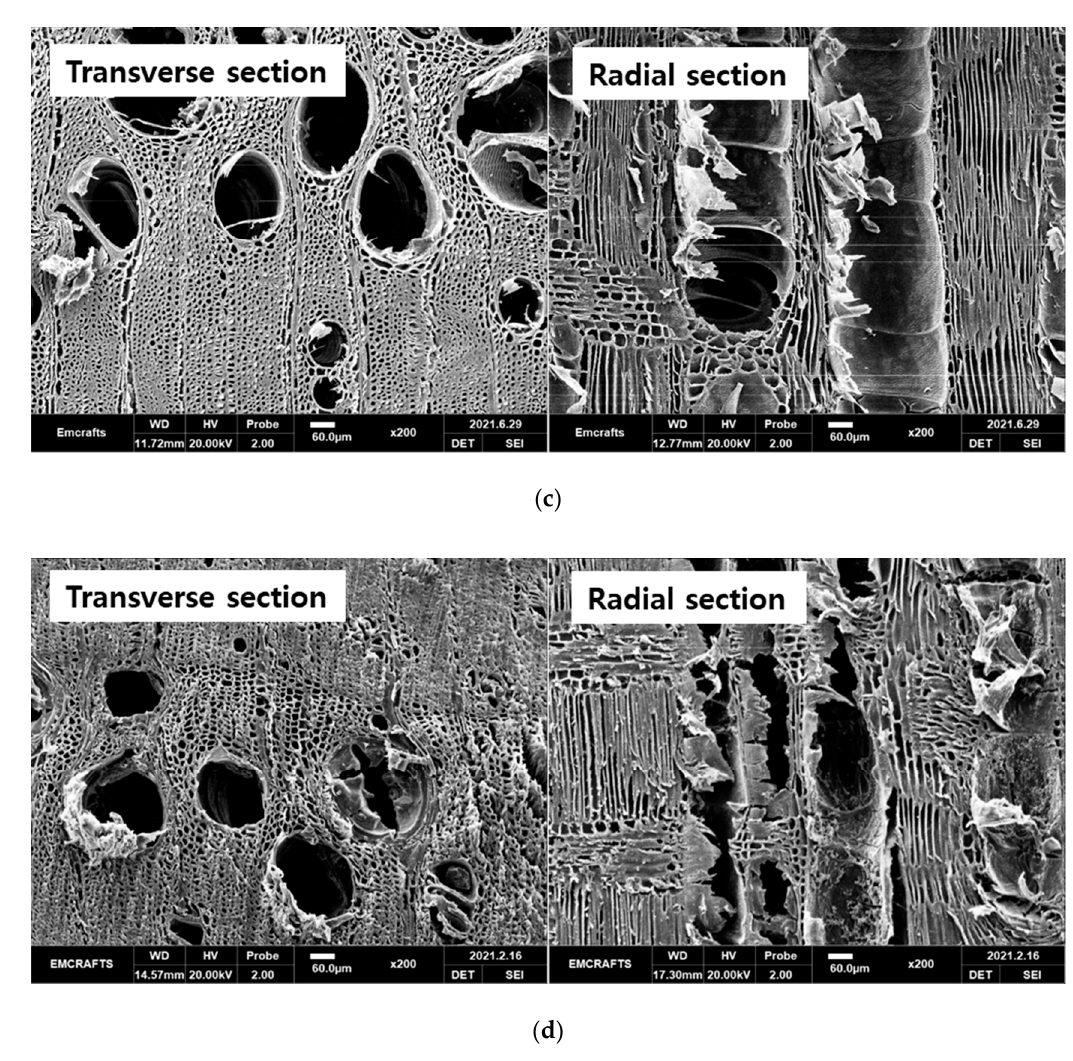
Figure 3. SEM images of momala and red toon before and after delignification treatment: ( a ) Untreated momala; ( b ) Delignificated momala; ( c ) Untreated red toon; ( d ) Delignificated red toon.